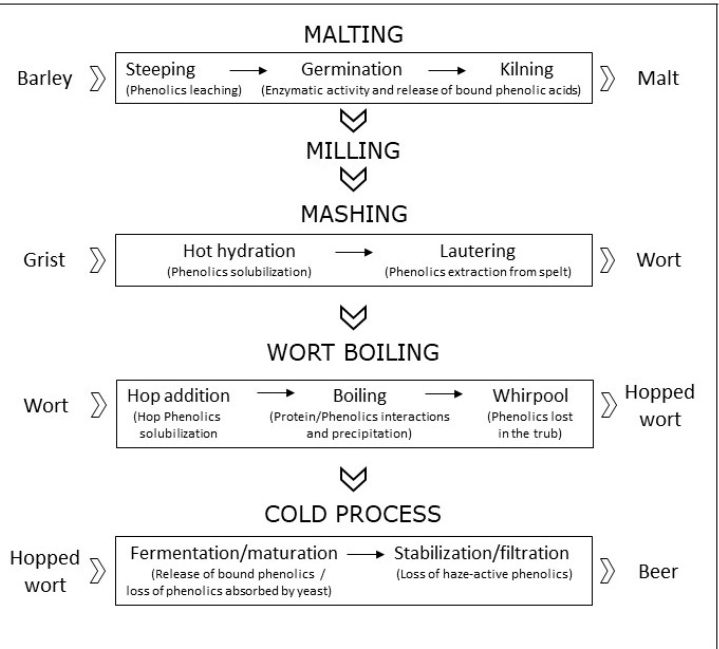
Figure 1. Phenolic compounds’ fate during the phases of malting and brewing processes: in the phase of mashing, after an initial decrease, total phenolics amount increases 3- to 5-fold; afterwards, phenolics continue to increase throughout mashing and during hop addition, but dramatically decrease during wort boiling, whirpool, fermentation, maturation, stabilization and filtration, so that, during the entire brewing process, about 60% of the malt phenolic content is lost.